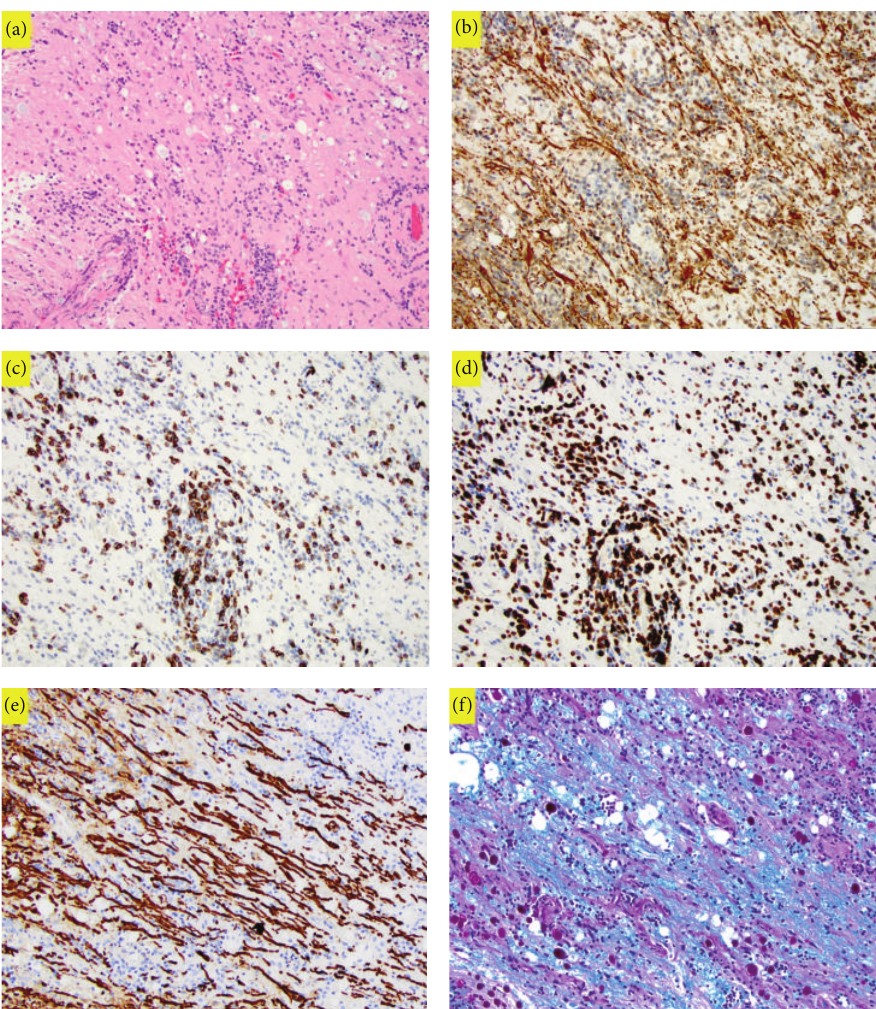
Figure 3: (a) Representative H&E section of lesional tissue (200x). There are perivascular and parenchymal infiltrates of lymphocytes. The blood vessel wall shows hyalinization changes and there is congestion in the capillaries. (b) Glial fibrillary acidic protein (GFAP) immunostains show focal gliosis (200x). (c) A few CD20 positive B cells are present (200x). (d) A few CD3 positive T cells are present (200x). (e) Neurofilament immunostain highlights axons (200x). (f) Luxol fast blue- (LFB-) periodic acid-Schiff (PAS) stains show intact myelin (200x). There is no evidence of glioma, lymphoma, demyelinating disease, granuloma, viral-cytopathic changes, fungal organisms, or mycobacterial